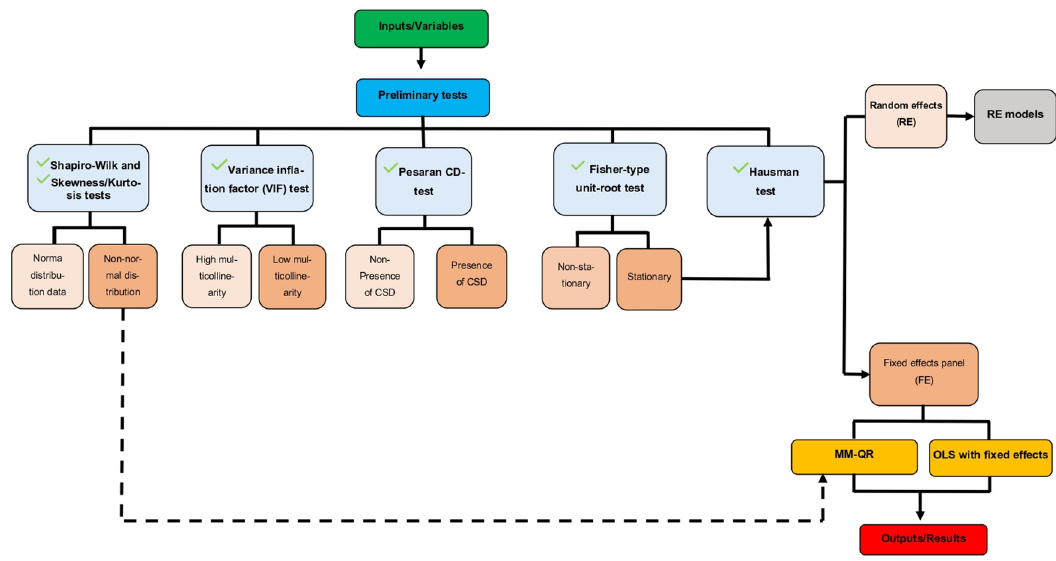
Figure 2. Methodology strategy. (The authors created this